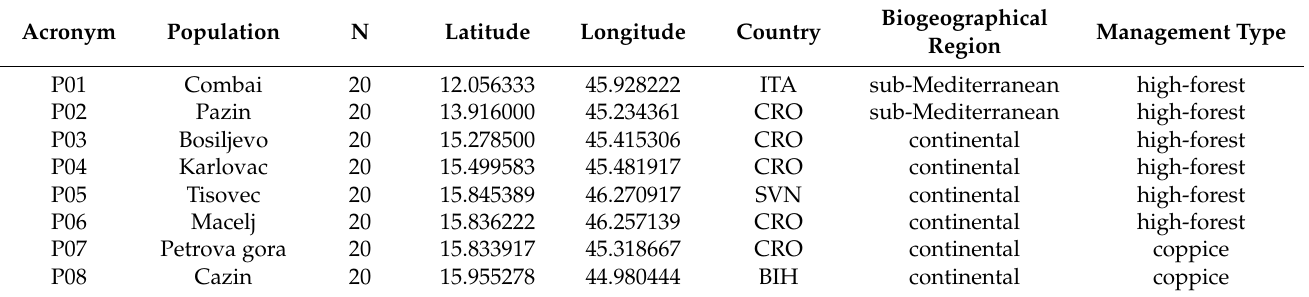
Table 1. Acronyms, sample size (N), geographic co-ordinates, countries, biogeographical regions, and management types for eight sweet chestnut ( Castanea sativa Mill.)